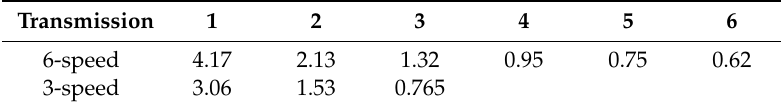
Table 1. Gear speed ratios, τ , of the 6-speed and 3-speed transmission devices.